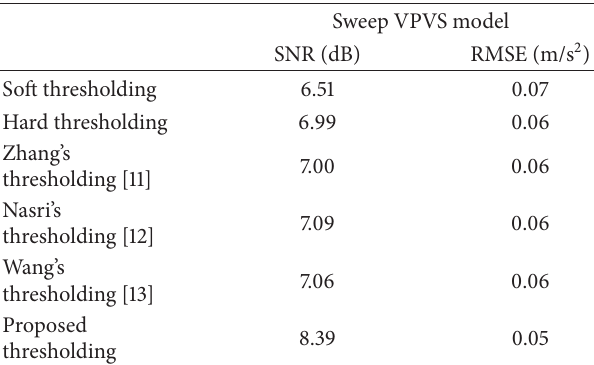
Table 3: The SNR and RMSE results of denoising methods.